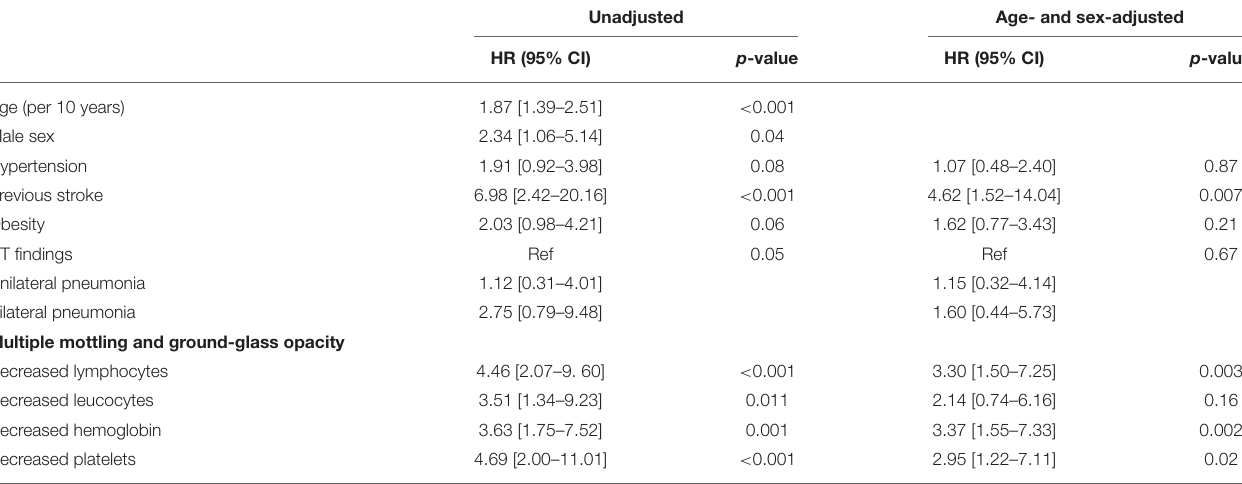
TABLE 2 | Association between previous stroke and severe COVID-19 pneumonia.